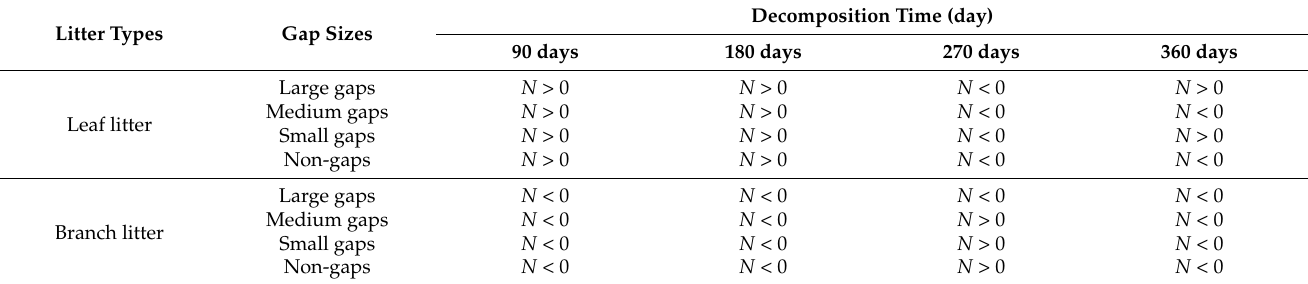
Table A5. Total nitrogen release of litter at different decomposition stages in different canopy gaps.